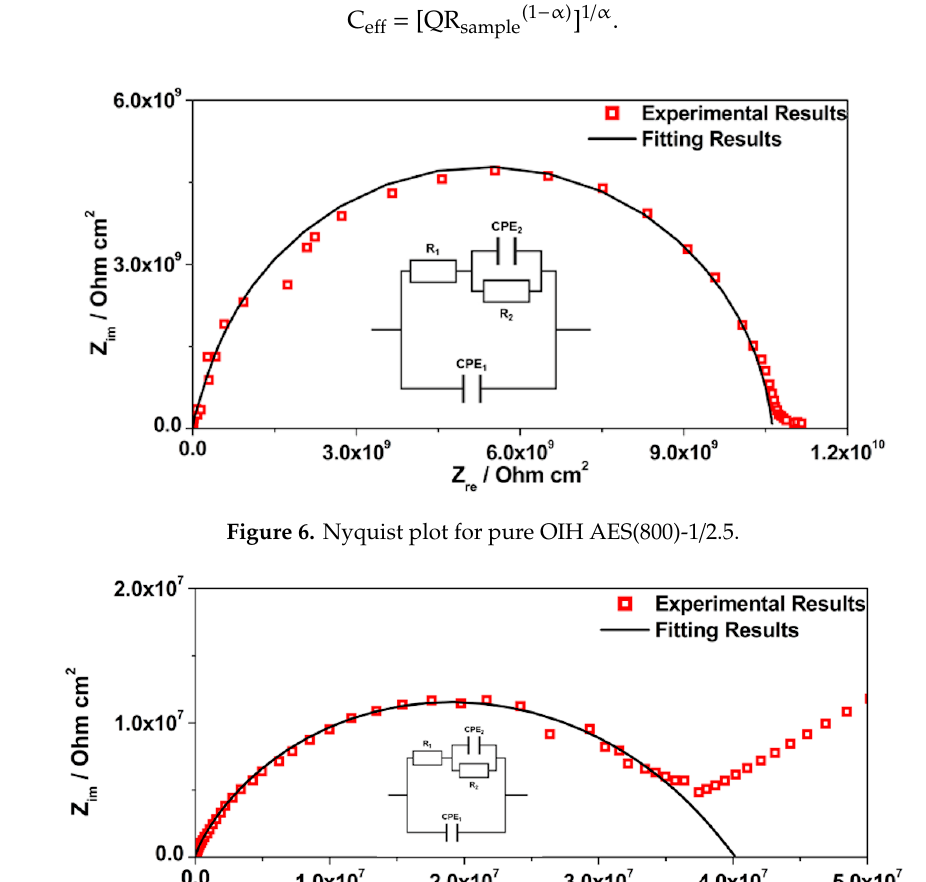
Figure 8. Nyquist plot for Phph doped OIH AES(800)-1/2-Phph films. Figures 5–7 show that at higher frequencies both Nyquist plots describe a semicircle, with the exception of the AES(800)-1/2.5 sample (Figure 6), which intersects the x-axis; none of the other samples displayed this behaviour. The amplitudes of the different samples change with their composition, and the undoped samples show the higher impedance magnitudes. The AES(800)-1/2 sample (Figure 5) showed the highest magnitude, and was followed by the AES(800)-1/2.5 (Figure 6). Sample AES(800)-1/5 showed the lowest magnitude. These differences are assigned to the dielectric properties of the OIH